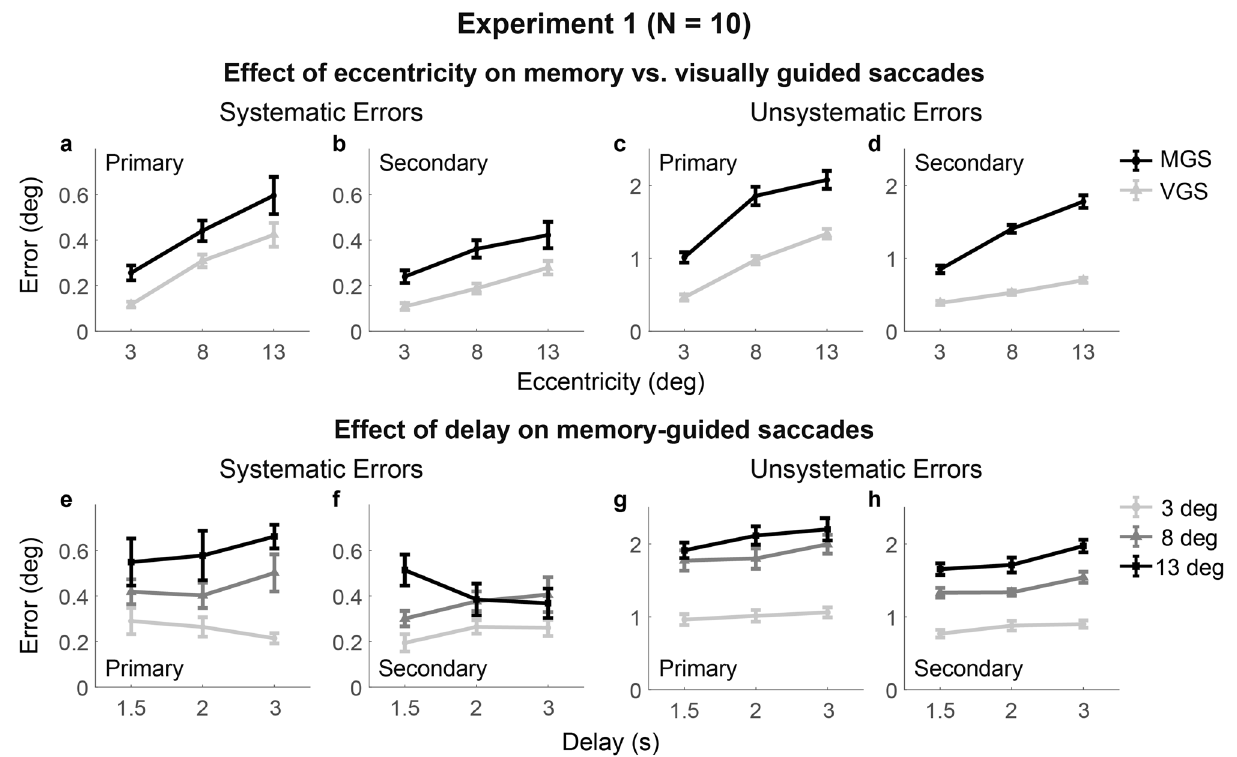
Figure 4. Saccade endpoint errors across tasks, eccentricities, and delays in Experiment 1. The top row shows errors in the MGS (black) and VGS (light gray) across different target eccentricities. The bottom row shows errors in the MGS across different delay intervals for each target eccentricity (3°, light gray; 8°, gray; 13°, black). Both systematic and unsystematic errors increased with increasing eccentricity, with a greater linear and quadratic increase in the MGS than in the VGS for the unsystematic errors. Unsystematic errors in the MGS accumulated from 1.5-s to 3-s delay intervals significantly for the primary and secondary saccades in a similar pattern across